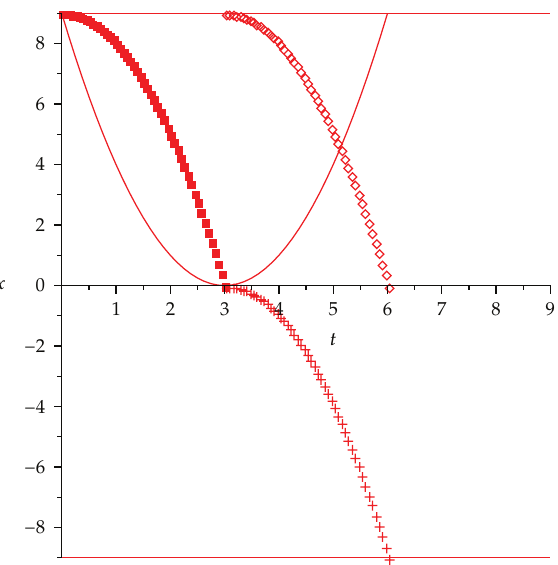
Figure 2: The illustrative graph of on (cid:25) x (cid:2) t (cid:3)